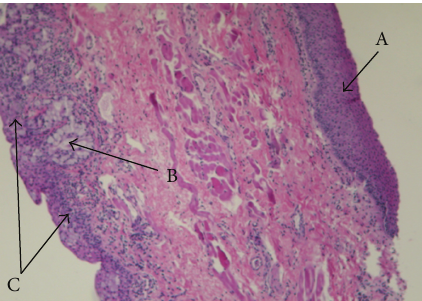
Figure 1: Histopathology of excised tissue. A: squamous epithelium of eyelid skin (epidermis) with no inflammation, B: goblet cells, and C: lichenoid lymphocytic inflammatory reaction in the conjunctival side of eyelid.